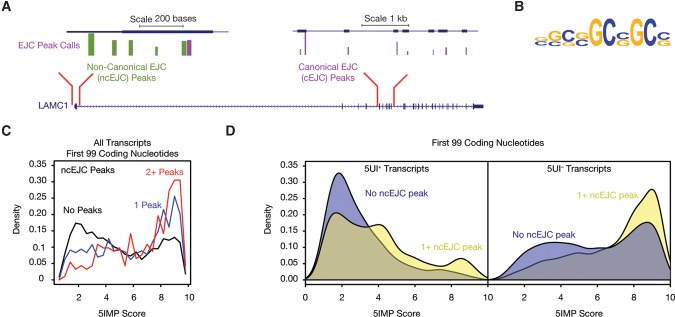
5IM transcripts harbor noncanonical exon junction complex (EJC) binding sites. (A) Observed EJC binding sites (Singh et al. 2012) are shown for an example 5IM transcript (LAMC1). Canonical EJC binding sites (purple) are ∼24 nt upstream of an exon–intron boundary. The remaining binding sites are considered to be noncanonical (green). (B) A CG-rich sequence motif previously identified to be enriched among ncEJC binding sites in first exons (Singh et al. 2012) is shown. (C) 5IMP score for transcripts with zero, one, two, or more noncanonical EJC binding sites in the first 99 coding nucleotides reveals that transcripts with high 5IMP scores frequently harbor noncanonical EJC binding sites. (D) Transcripts with high 5IMP scores are enriched for noncanonical EJCs regardless of 5UI presence or absence.